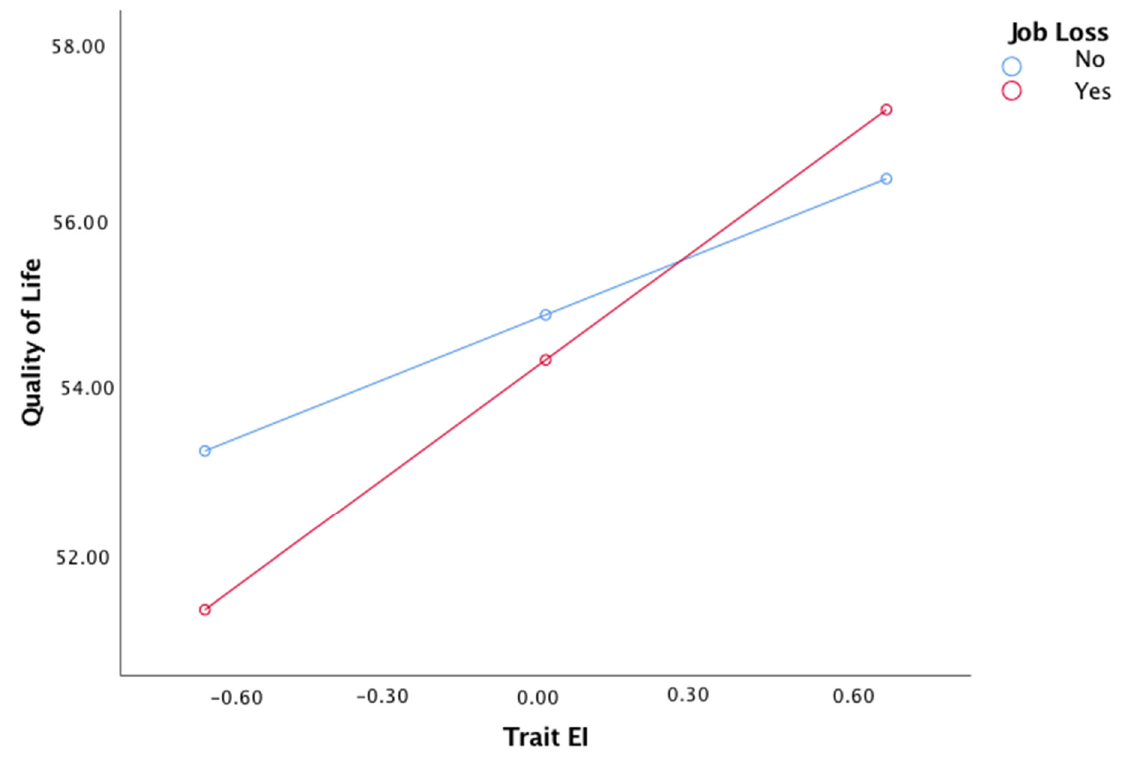
Figure 3. Data plot of simple slope interaction for job loss × trait EI on Quality of Life.